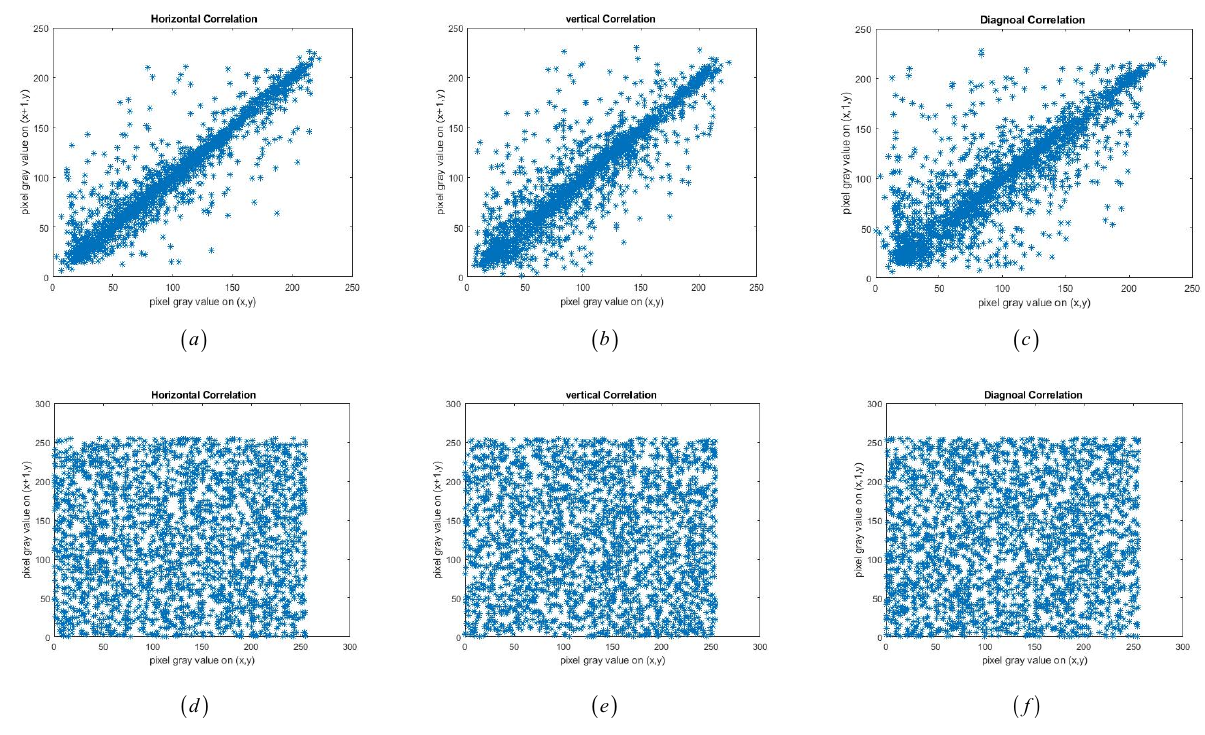
Figure 13. Correlation (128 × 128): ( a – c ) correlation of horizontal, vertical, and diagonal directions of the Lena graph, respectively; ( d – f ) correlation of horizontal, vertical, and diagonal directions of Lena encrypted graph, respectively. Table 6. Comparison of average correlation of ciphertext.